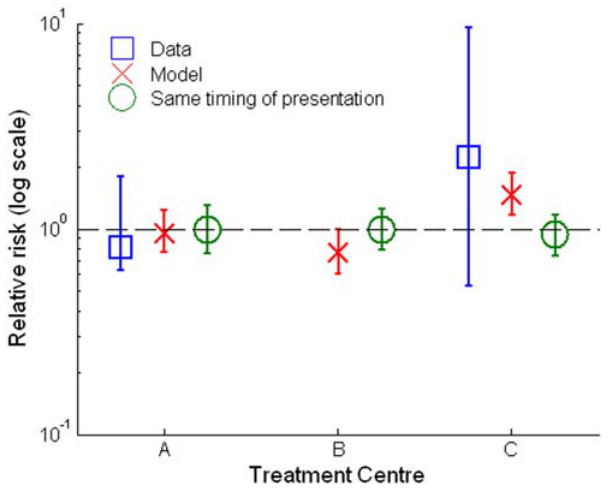
Figure 2. Observed and modeled risk of dying in first three- years of ART relative to national average. Errorbars show 95% confidence interval (data) or inter-quartile range from 500 simulations